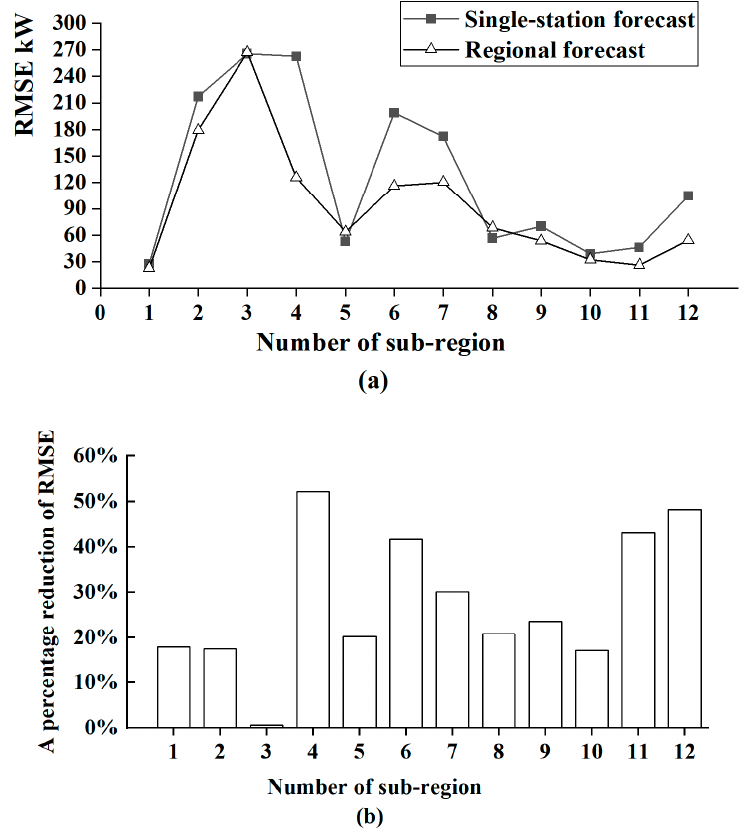
Figure 8. Forecast results based on small-area partition ( a , b ).